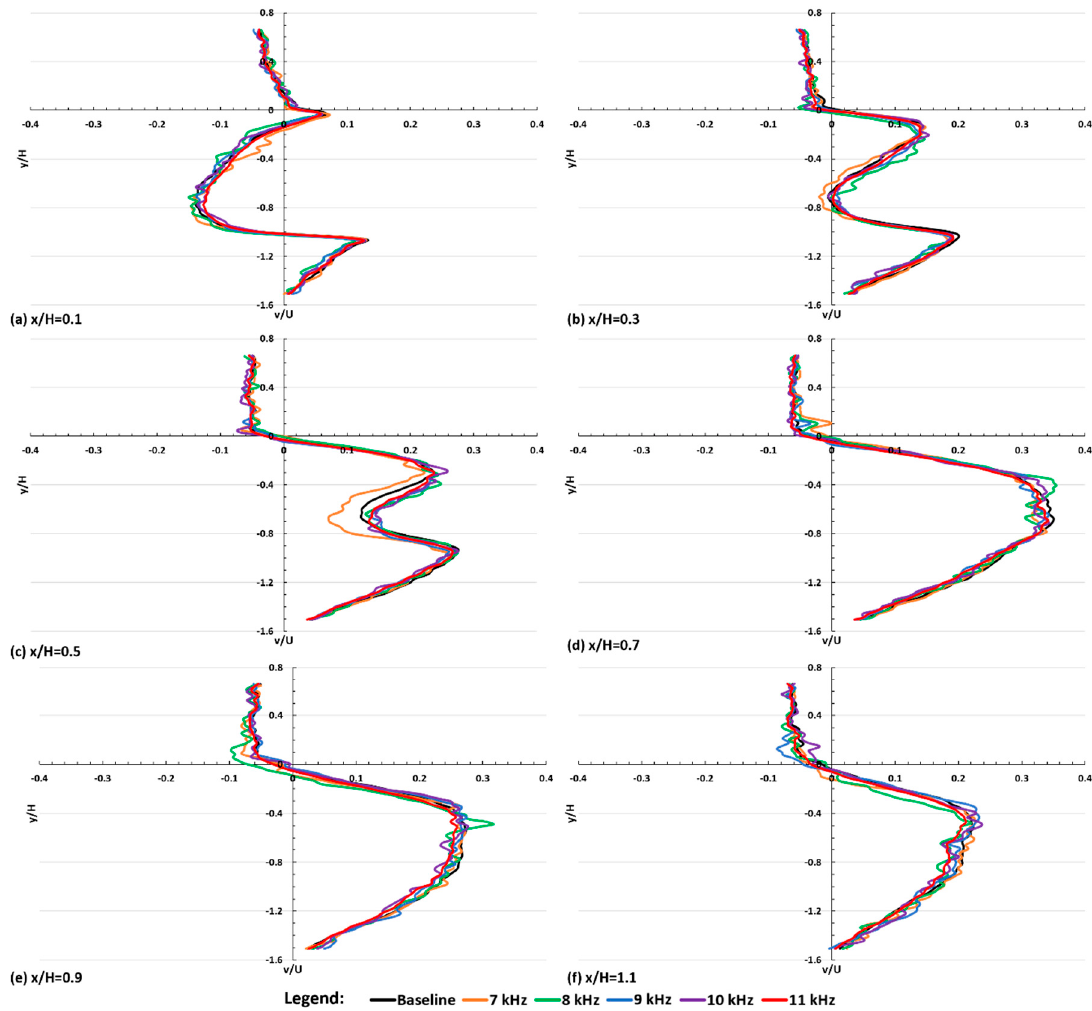
Figure 13. Normalised y-velocity profiles measured at various normalised x-locations along the wake region. x / H = ( a ) 0.1, ( b ) 0.3, ( c ) 0.5, ( d ) 0.7, ( e ) 0.9, and ( f ) 1.1.